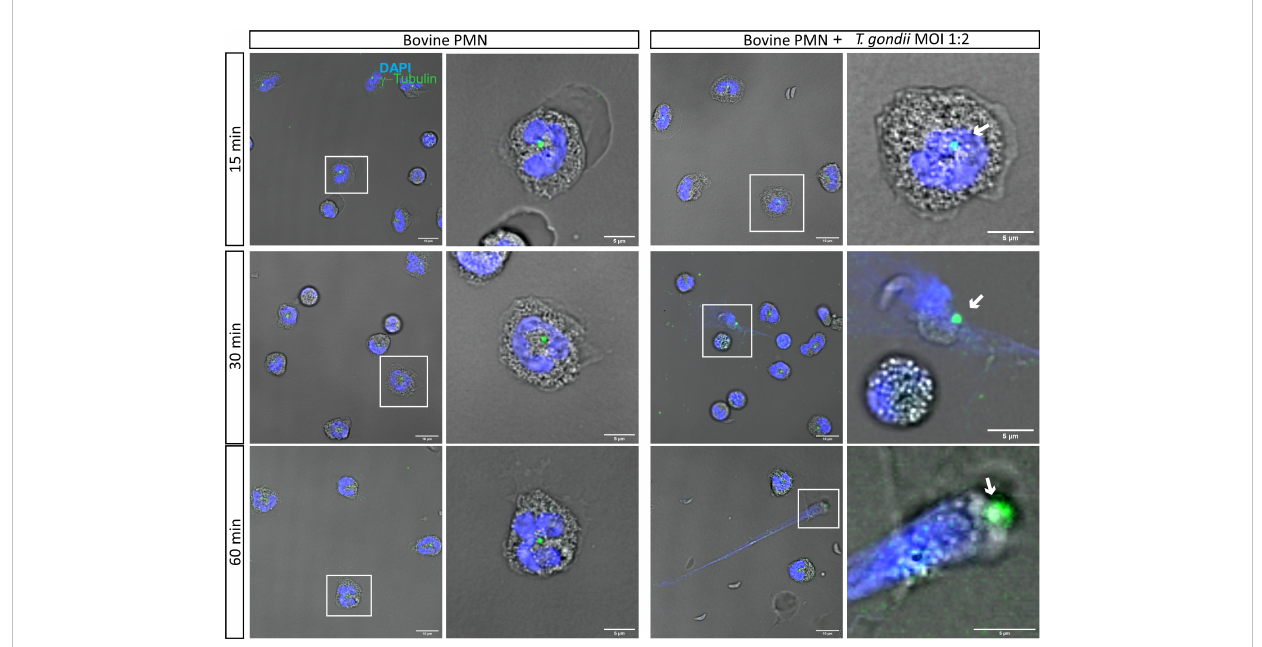
FIGURE 3 T. gondii tachyzoite exposure does not induce centrosome duplication in bovine PMN. 2 × 10 5 bovine PMN were confronted with vital 4 × 10 5 T.gondii tachyzoites (1:2 ratio) for 60 min. Samples were fi xed in PFA 4% at 15, 30 and 60 min of co-culture and the specimens were stained the centrosome marker g -tubulin (green channel) and DNA (blue channel; DAPI). In white squares the cells which are zoomed in the corresponding right panel are shown. Centrosomes are indicated by a white arrow. Scale bars correspond to 10 µm and 5 µm in zoomed